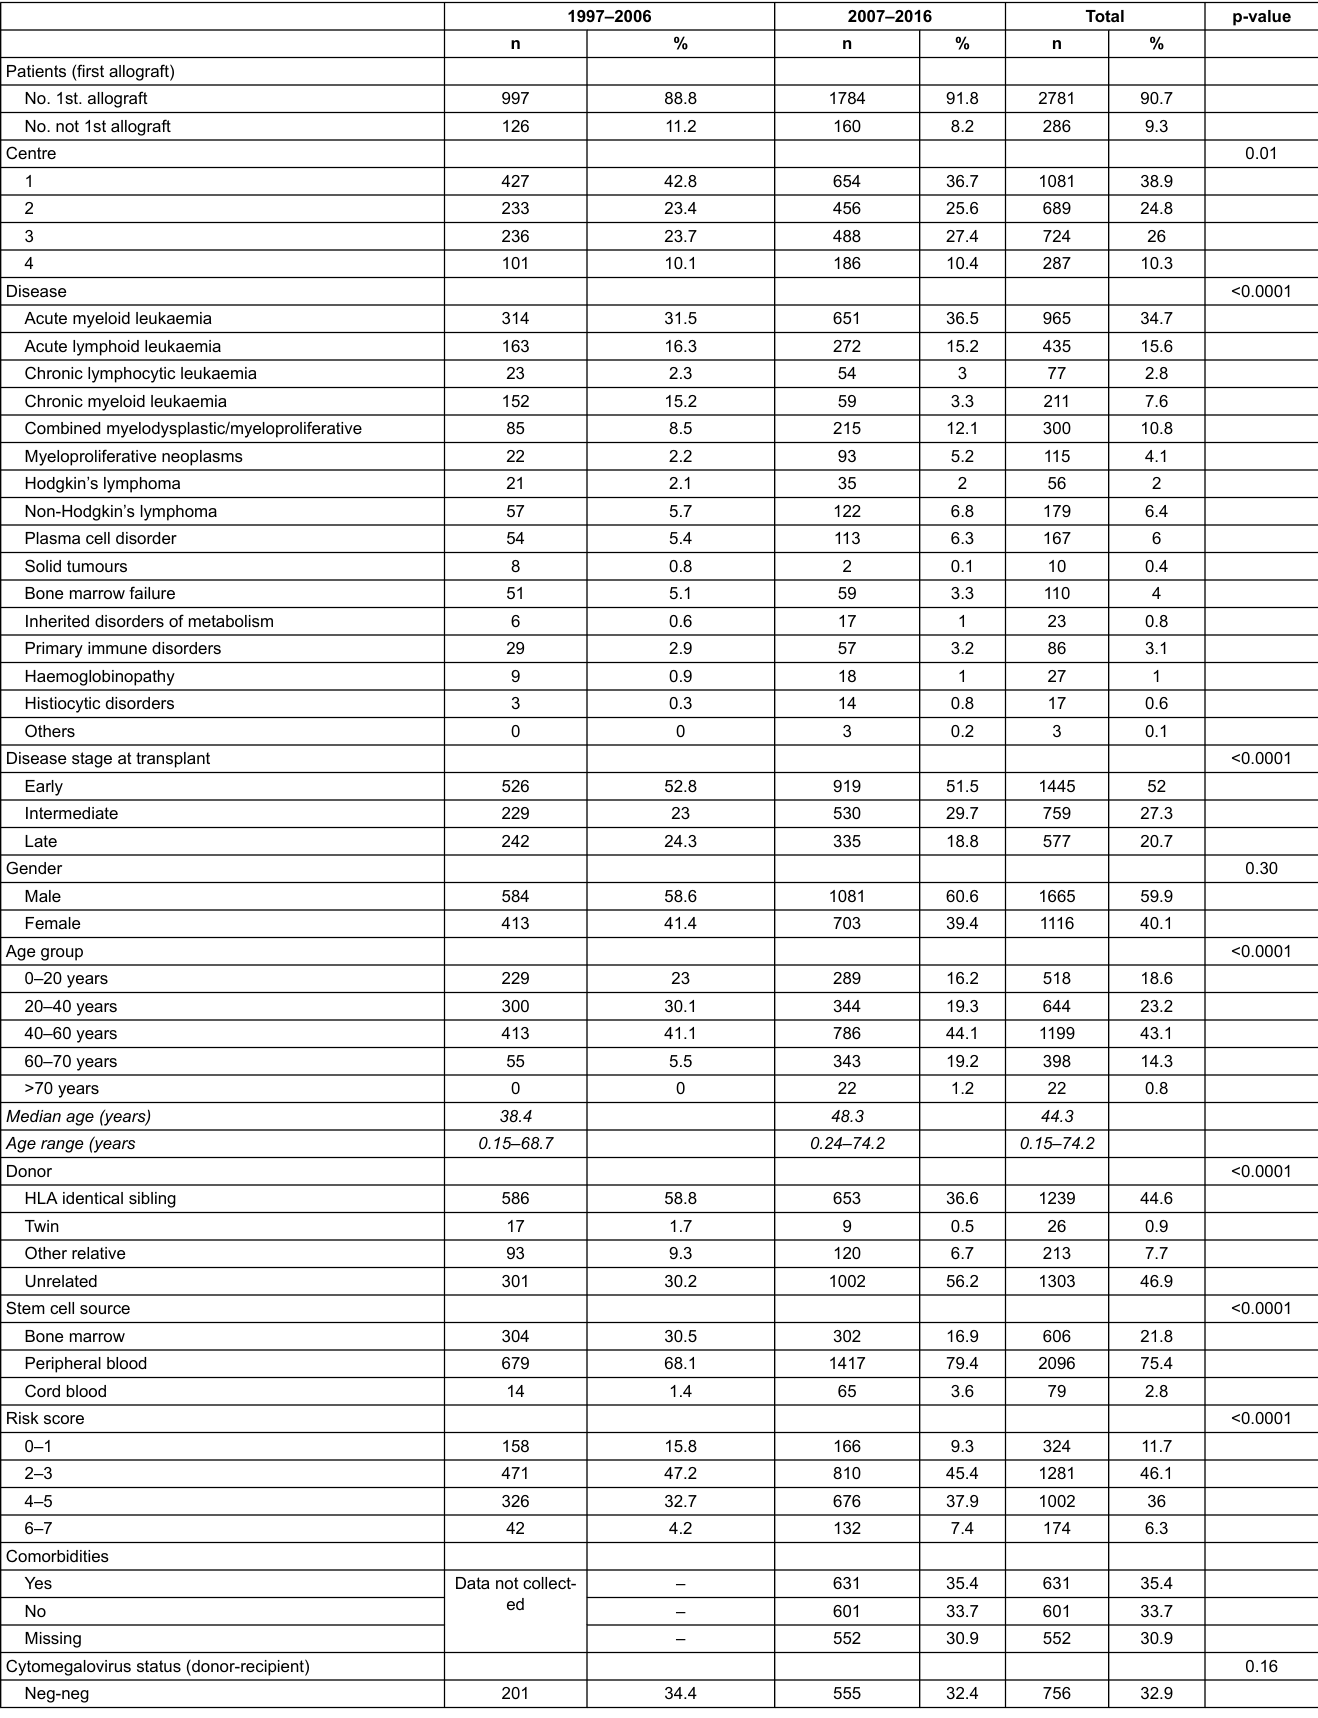
Table 1: a: Demographic characteristics and transplant technology for allogeneic haematopoietic cell transplants by decade for the years